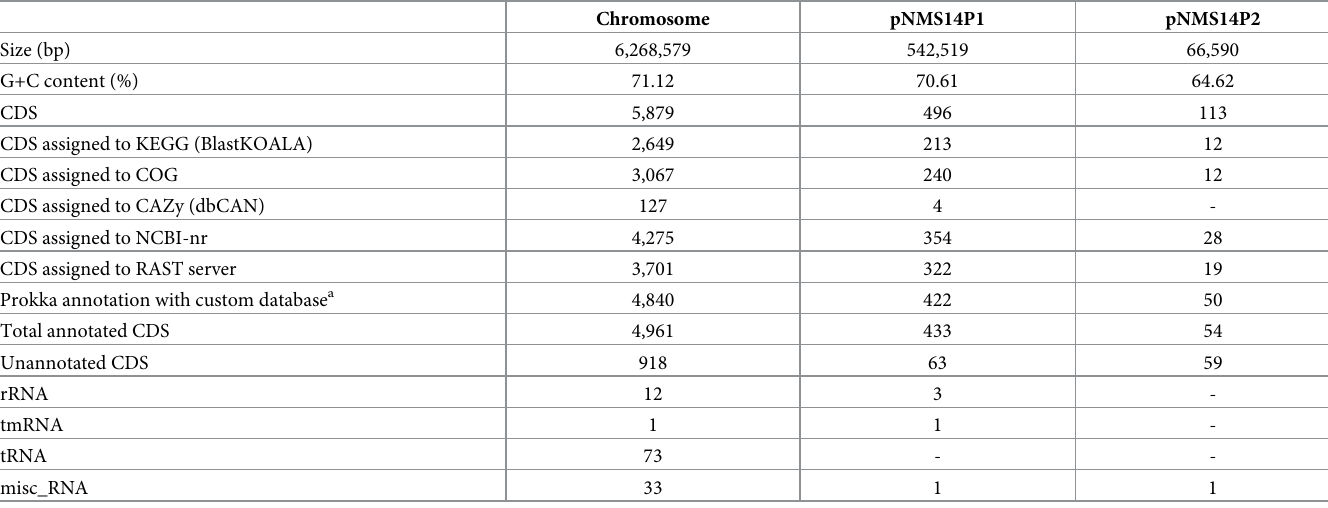
Table 2. Genome structures and general features of